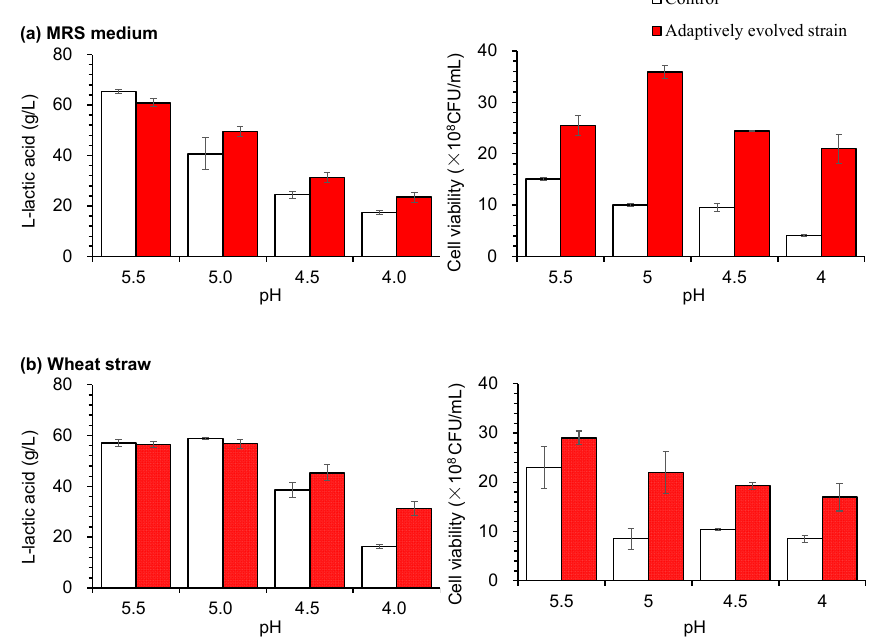
Figure 3. L-lactic acid fermentability of the adaptively evolved P. acidilactici strain at different pH values in de Man, Rogosa and Sharpe (MRS) medium and simultaneous saccharification and co- fermentation (SSCF). ( a ) MRS medium; ( b ) wheat straw. The parental strain P. acidilactici ZY271 was used as the control. The fermentation in MRS medium was conducted in 1 L fermentor containing 90 g/L of glucose for 48 h. The SSCF was performed using biodetoxified wheat straw under 15% ( w / w ) solids loading for 48 h. The condition was controlled at 42 °C and 400 rpm, and the pH was controlled at different values (5.5, 5.0, 4.5, and 4.0) by automatic adding 4 M NaOH. The sugar con- sumption, L-lactic acid generation, and cell viability were indicated at the end of the fermentation.